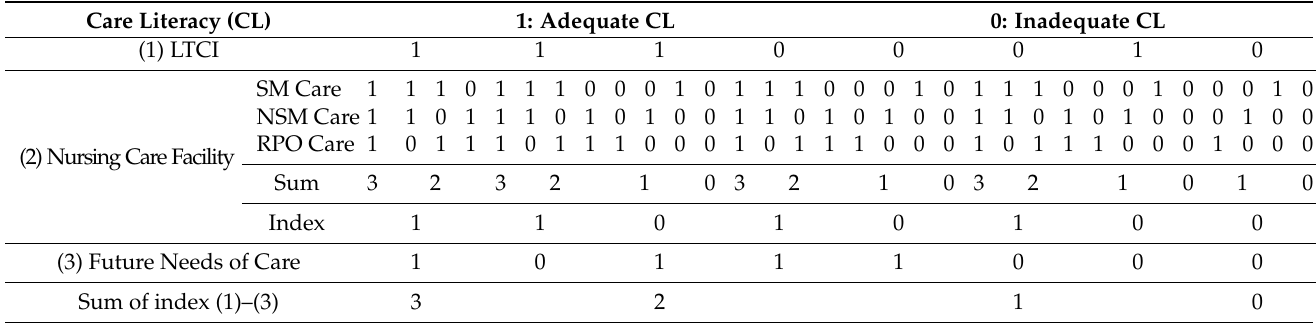
Table 1. Details of the setting for the comprehensive index of CL.